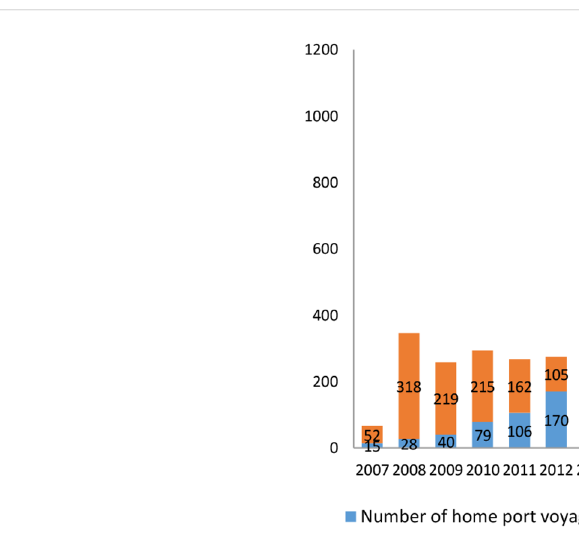
FIGURE 2 Voyage Statistics in Mainland China from 2007 to 2019.